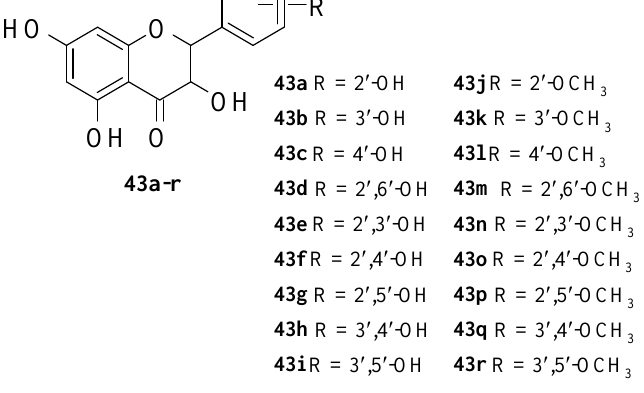
Figure 10. Chemical structures of new flavanonol derivatives [42].